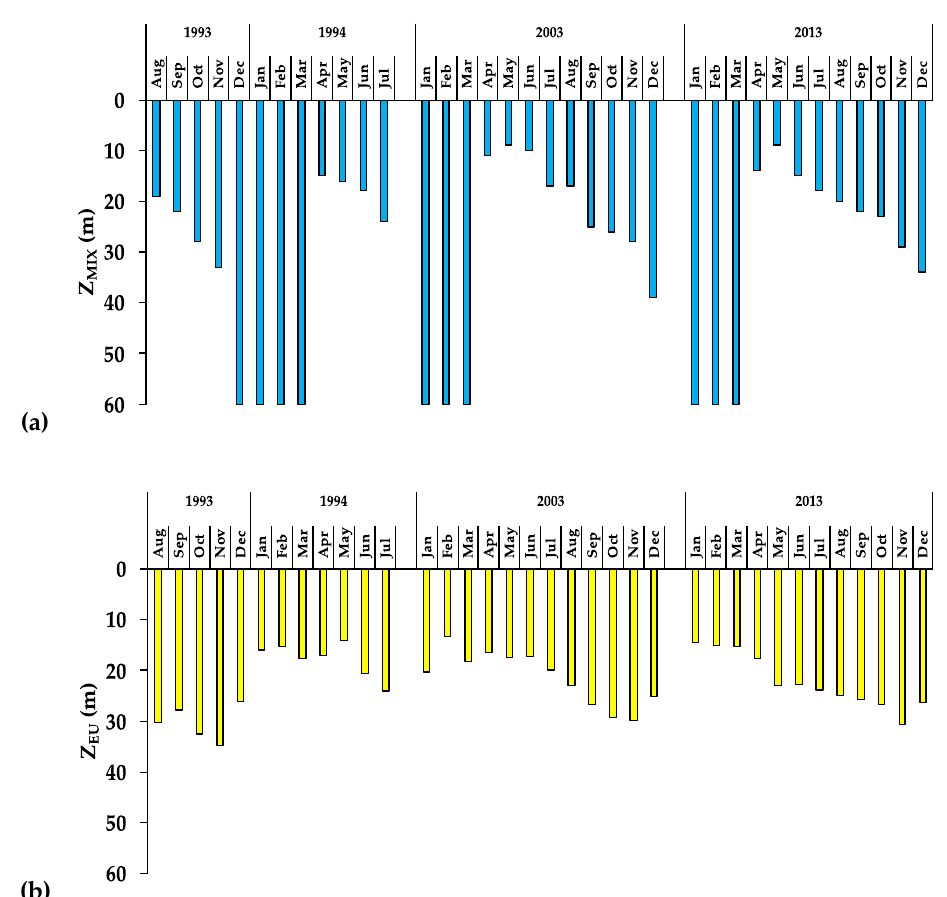
Figure 6. Temporal dynamics of the ( a ) mixing zone (Z MIX ) and the ( b ) euphotic zone (Z EU ) in Lake Alchichica. (Please note, the 1993–1994 cycle begins in August, while 2003 and 2013 in January).